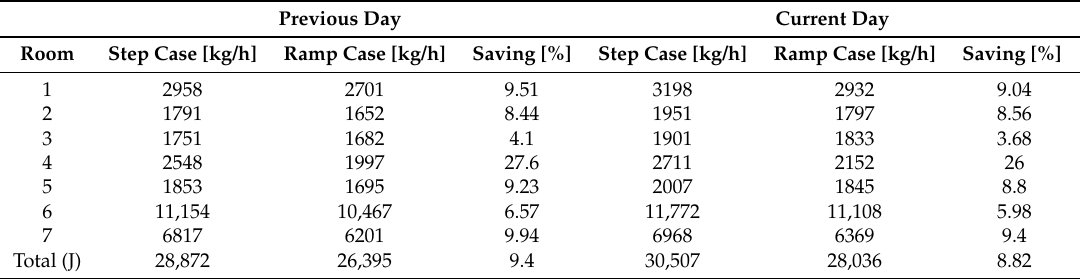
Figure 9. Results obtained by simulating the TRNSYS model of room 3 with fan-coil units for one day, 5 December. Table 6. Performance index value (4) for radiators in both step and ramp case evaluated by applying the optimal set-point signals with the TRNSYS model using weather conditions of the previous days (4 December, i.e., those used by the genetic algorithm) and of the current day (5